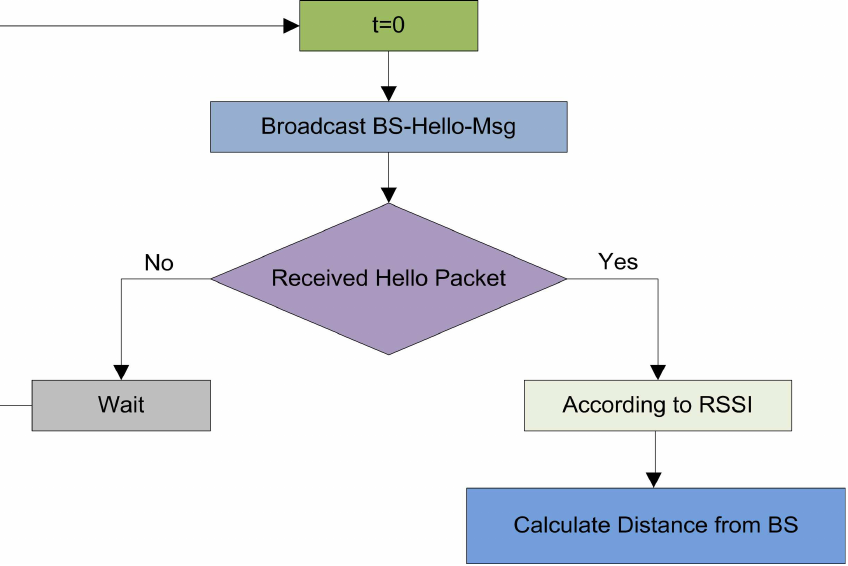
Figure 1. The network initialization and